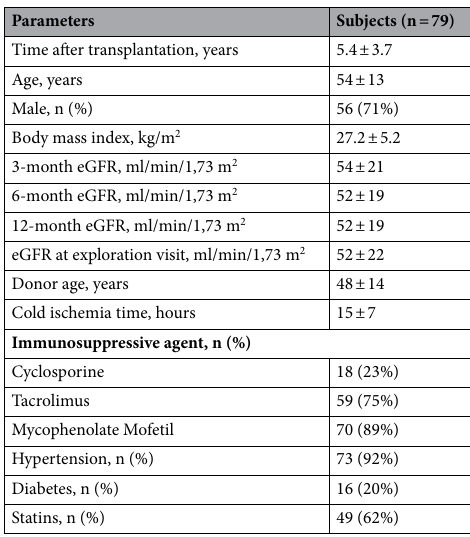
Table 1. Clinical characteristics of kidney transplant recipients. Data are mean ± SD or n (%).eGFR: estimated glomerular filtration